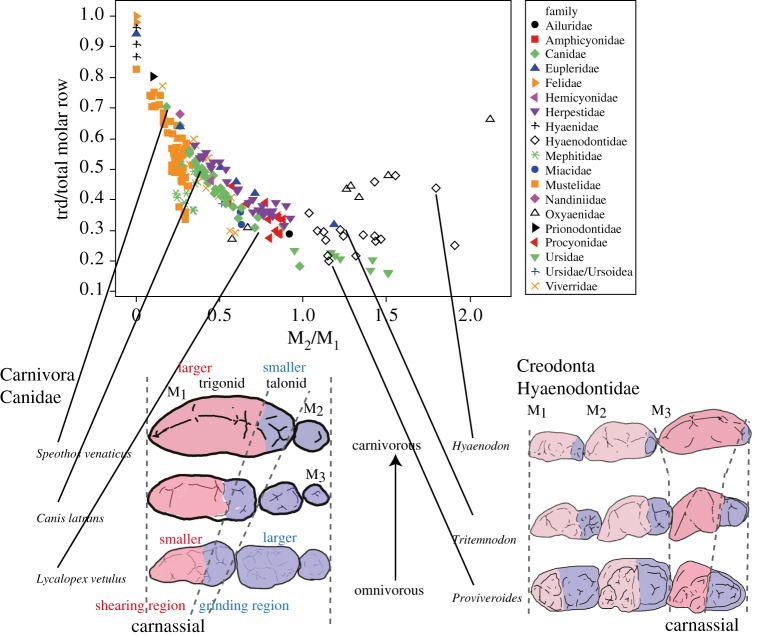
Variability in the relative trigonid size of the carnassial in relation to the total molar row in Carnivora and Creodonta. Plot of trigonid size of the carnassial (trd) divided by total molar row, with illustrations of diversity in molar rows among Canidae (Carnivora) and Hyaenodontidae (Creodonta). Trigonid of the carnassial is shown in deep red. The relative carnassial-trigonid size varied more highly in Carnivora than in Creodonta.